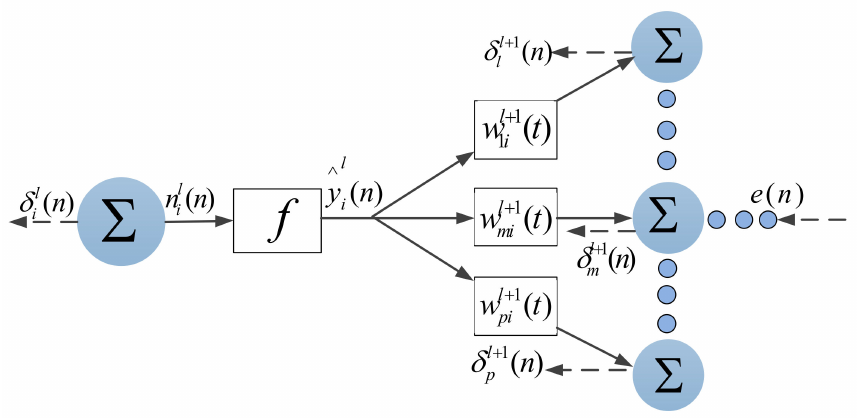
Figure 4. The EBP computing method for